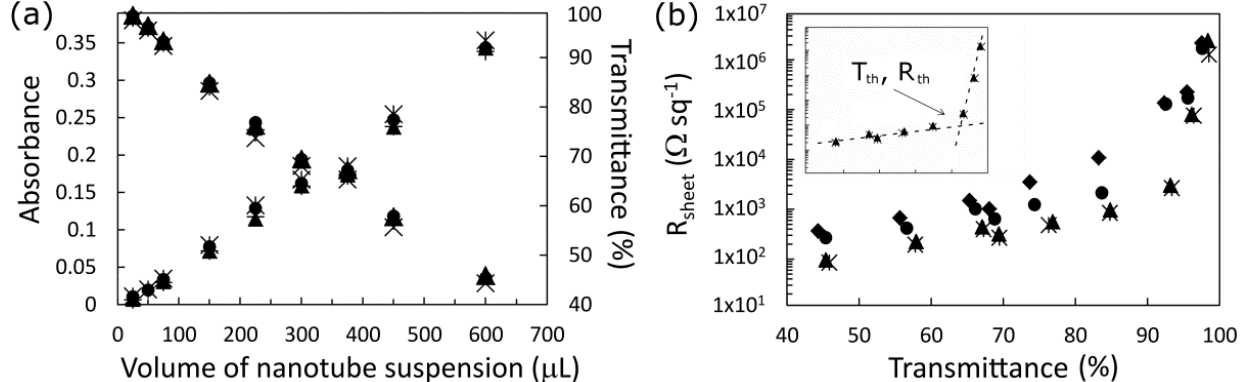
Figure 2. ( a ) Dependence of the SWCNT films’ average optical depth on the volume of SWCNT suspension used per square centimeter of filtration membrane. The different symbols represent different treatments and show very that there is very little effect on the baseline visible absorption; ( b ) Variation of the sheet resistance with film transmission for treated (  ) and HCl retreated (  ) devices. Inset as prepared (  ), HCl treated (  ), SOCl 2 shows the two regions of differing resistance for the doped films and the threshold transmittance ( T ) and corresponding sheet resistance ( R th th